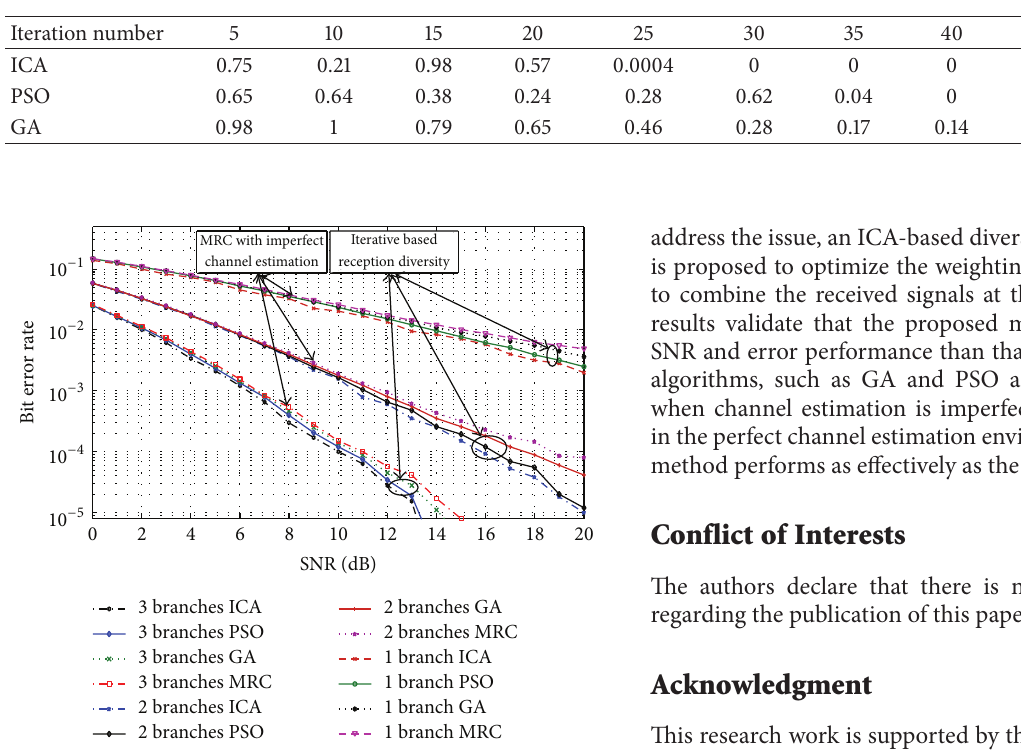
Figure 6: Error performance of ICA-, PSO-, and MRC-based methods for different numbers of diversity branches.